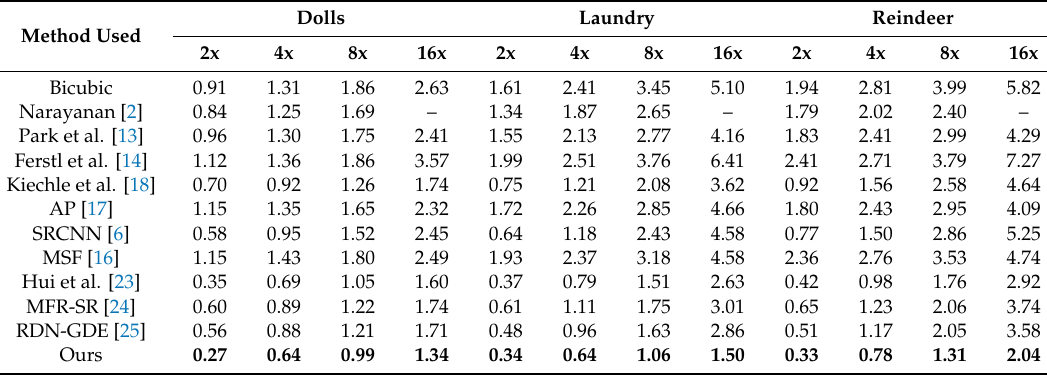
Table 2. Quantitative comparison (in RMSE) on dataset B .